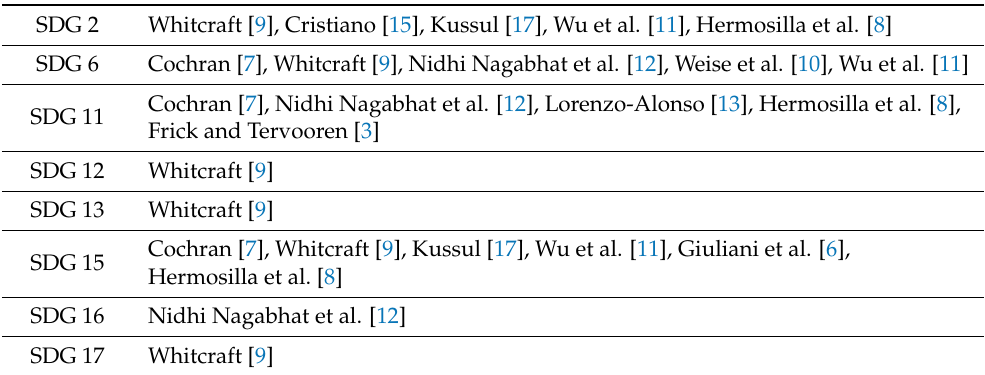
Table 1. Mapping of recent research results to the Sustainable Development